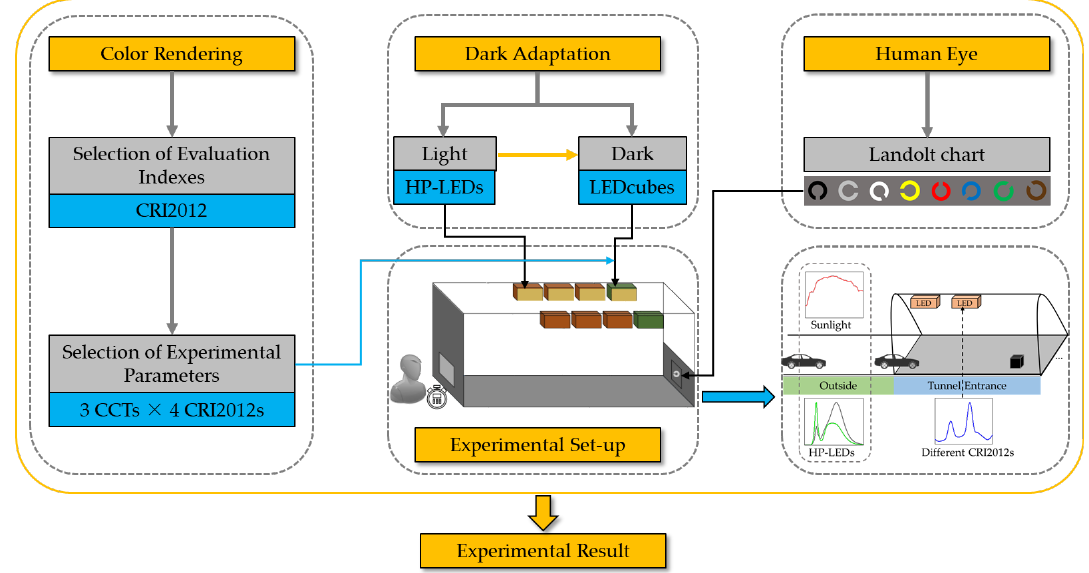
Figure 1. Overview of each part of the article. CRI2012 indicates a color di ff erence-based color rendering index; CCT = correlated color temperature; LED = Light-Emitting Diodes; HP-LEDs = high power LEDs; LEDcube indicate a kind of LED lamp.